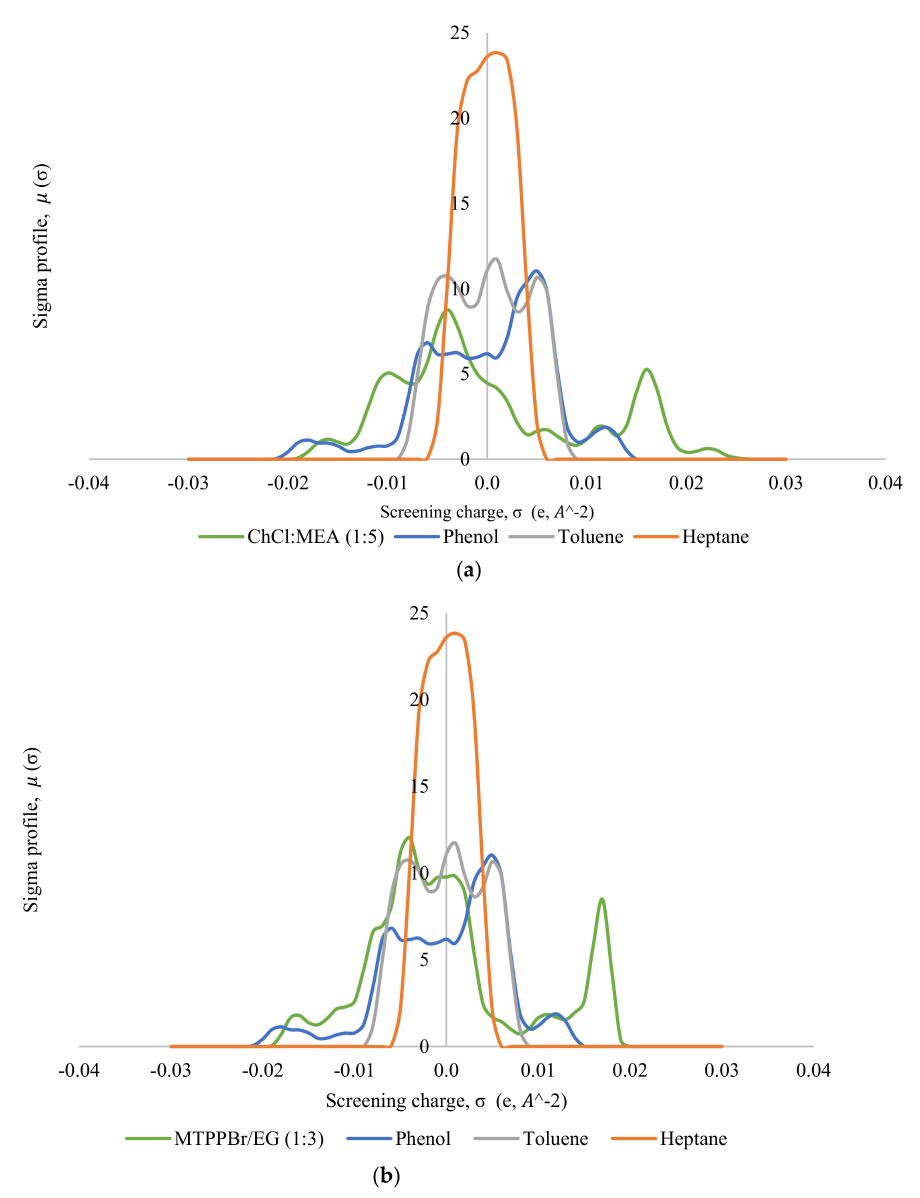
Figure 5. σ -profiles of species in the phenol-containing system; ( a ) is for the system containing the DES ChCl:MEA (1:5), and ( b ) is for the system containing the DES MTPPBr/EG (1:3). Phenol shows a symmetric σ -profile with peaks in both H-bond acceptor and H-bond donor regions. The peak at +0.005 eA − 2 for phenol indicates the π -face of the aromatic ring, and the peak at − 0.006 eA − 2 is due to the polarized hydrogens. The hydroxyl